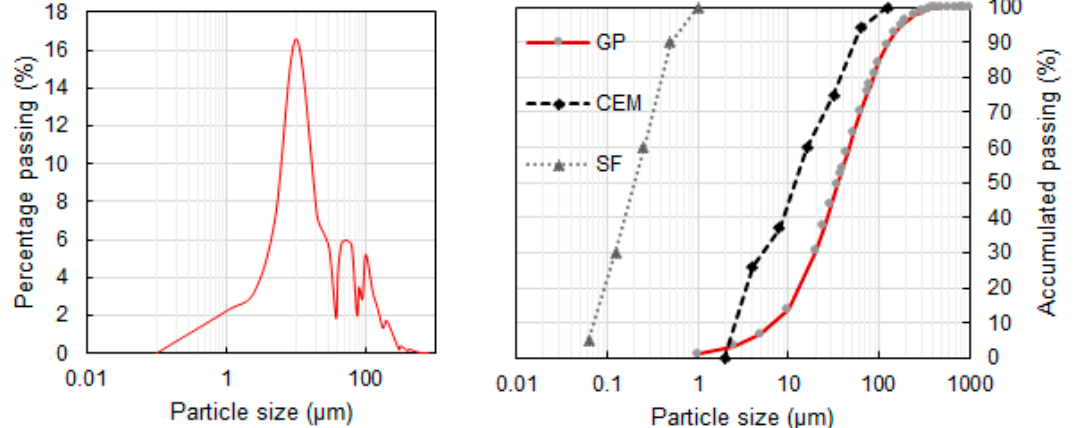
Figure 1. X-ray diffractogram of the studied GP.